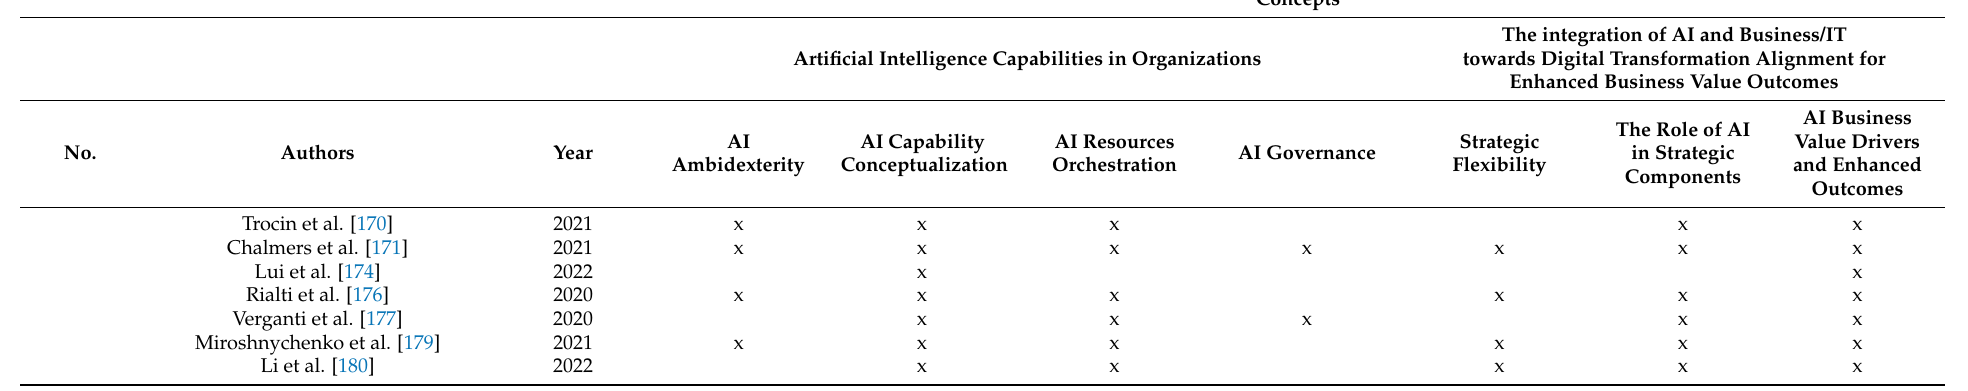
Table A5. Concept matrix table. Source: Own